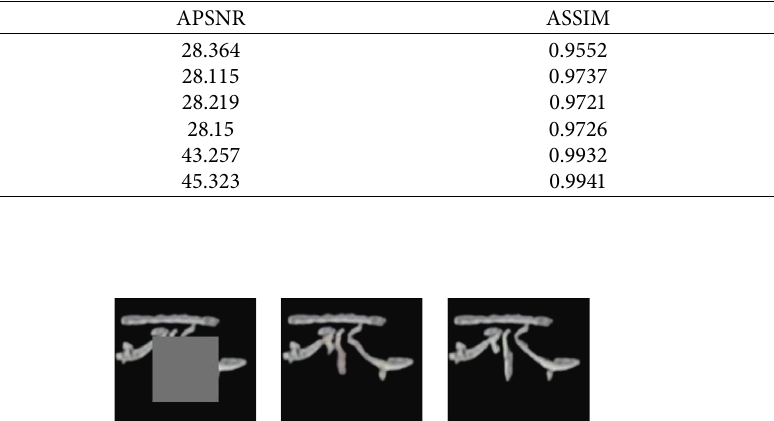
Table 1: Comparison of different denoising methods (APSNR, ASSIM, and ACEI).